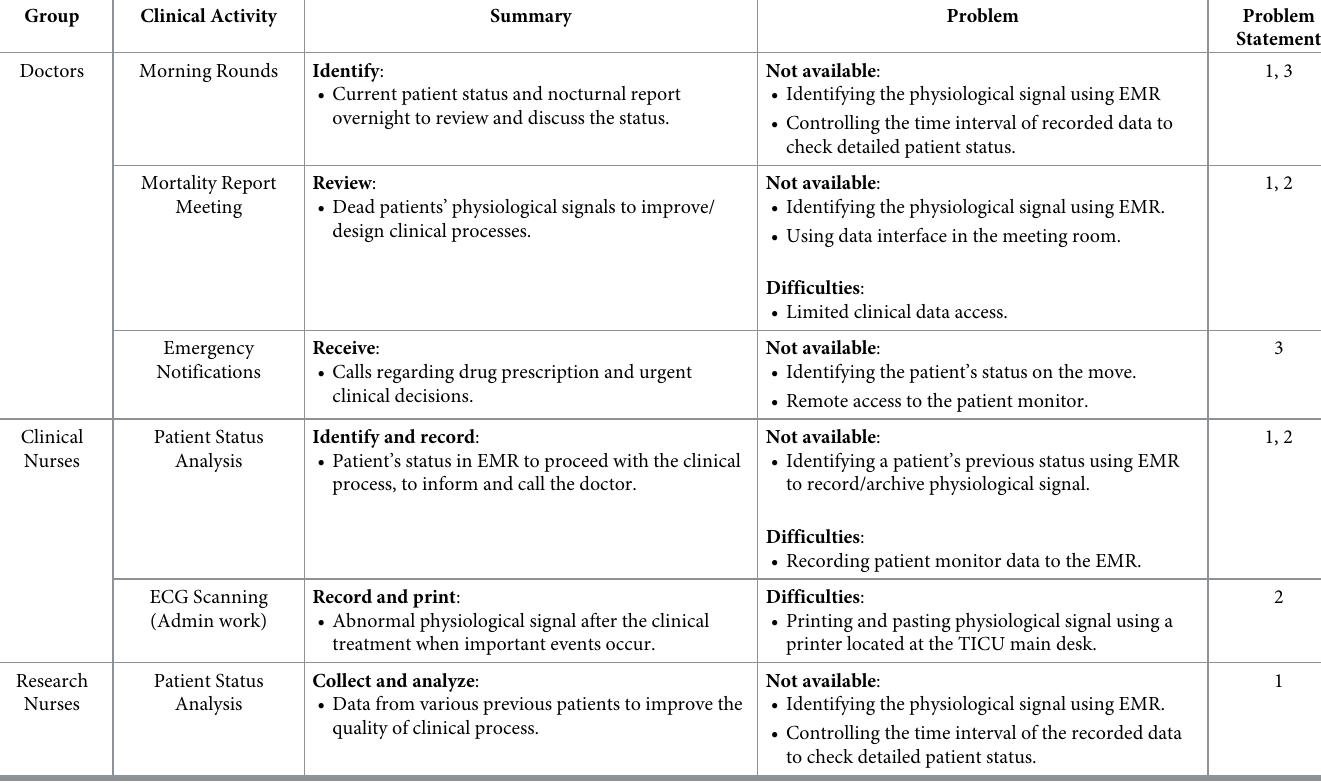
Table 2. Summary of user groups’ work activities and the primary issues they face regarding the usage of computer systems for accessing clinical data. For each of the points, we present how these issues map to the problem statement numbers discussed in Section 5. Group